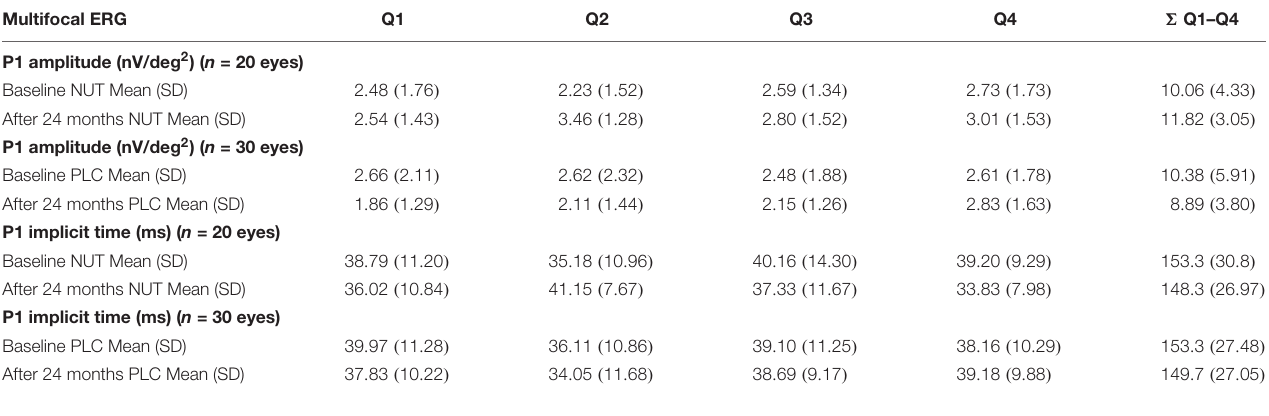
TABLE 4 | P1 amplitude and implicit time of mfERG recordings at baseline and 24 months after nutritional